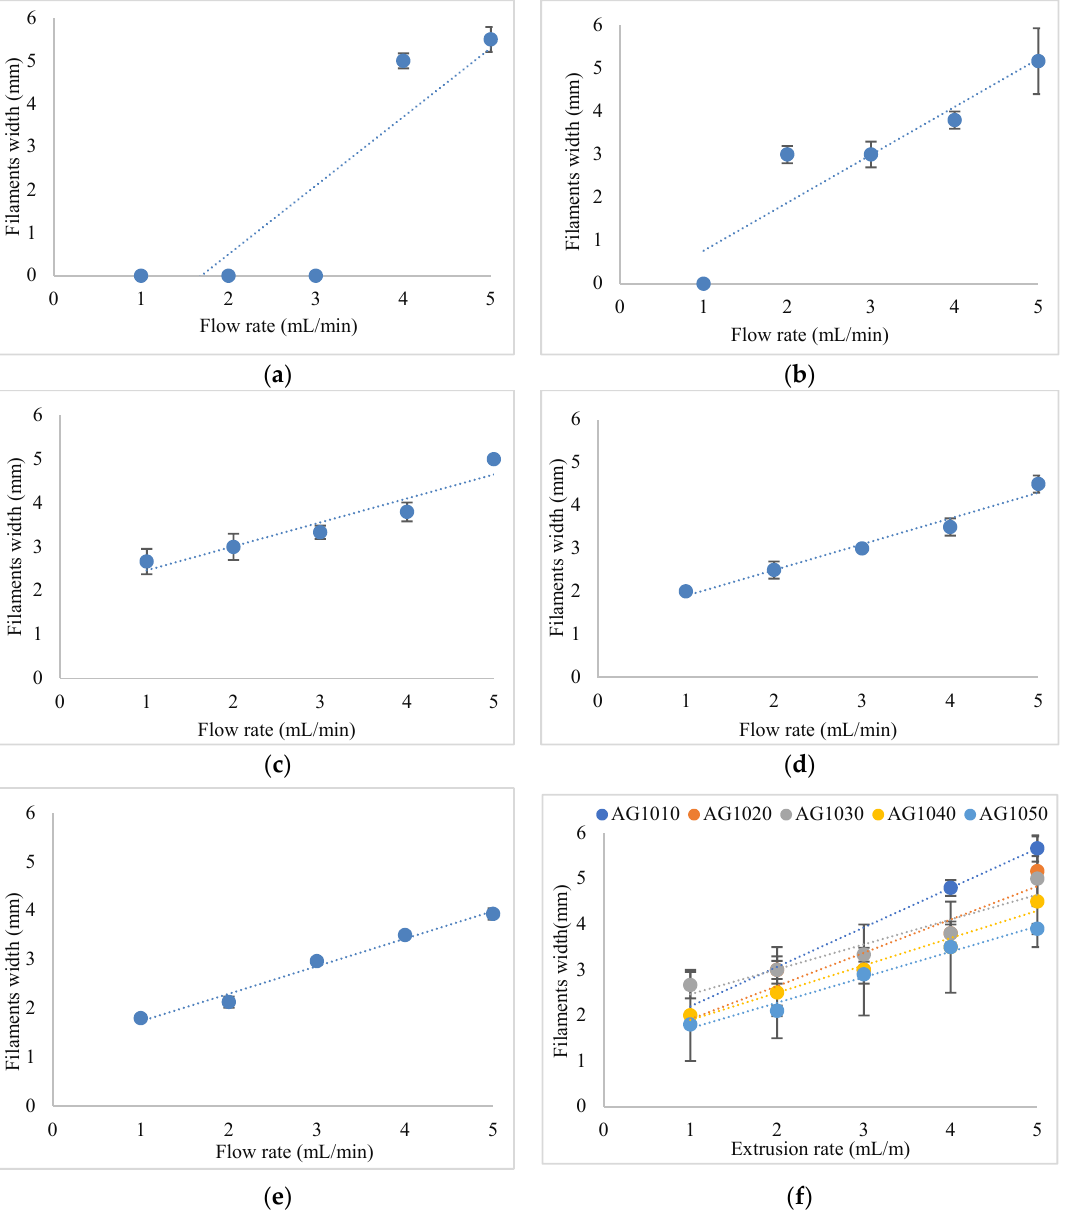
Figure 3. The results of the printed pattern of AG10:10–50 gel blends at different flow rates (1–5 mL/min) using an extrusion-based 3D bioprinter. ( a ) AG10:10; ( b ) AG10:20; ( c ) AG10:30; ( d ) AG10:40; ( e ) AG10:50; ( f ) AG10:(10–50).